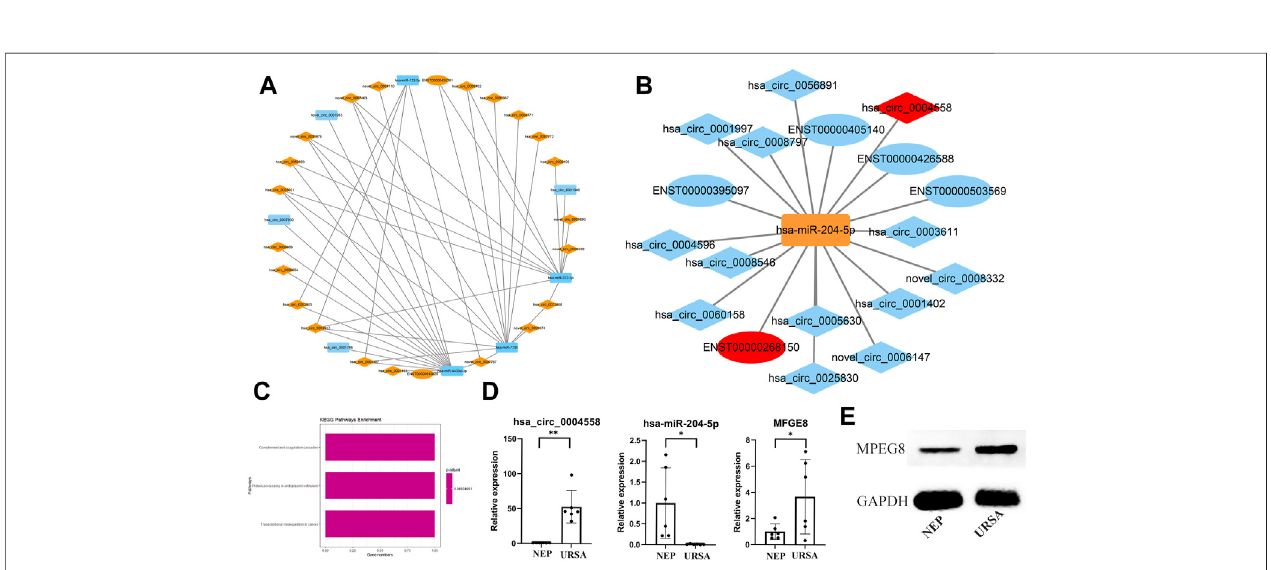
FIGURE 5 | Establishment of a ceRNA network and validation of the expression of has-miR-204-5p and MFGE8. (A) circRNA (down in URSA)-miRNA (up in URSA)-mRNA (down in URSA). (B) circRNA (up in URSA)-miRNA (down in URSA)-mRNA (up in URSA), RNAs marked in red are most likely to participate in the pathogenesisofURSA. (C) TheKEGGpathwayofmRNAinvolvedinceRNA. (D) Theexpressionofhas-miR-204-5p/MFGE8indeciduaofURSAandNEPbyRT-qPCR. (E) The expression of MFGE8 in decidua of URSA and NEP by western blot analysis. The rectangles indicate miRNAs, ellipses represent mRNAs, and diamonds represent circRNAs, * p < 0.05, ** p <